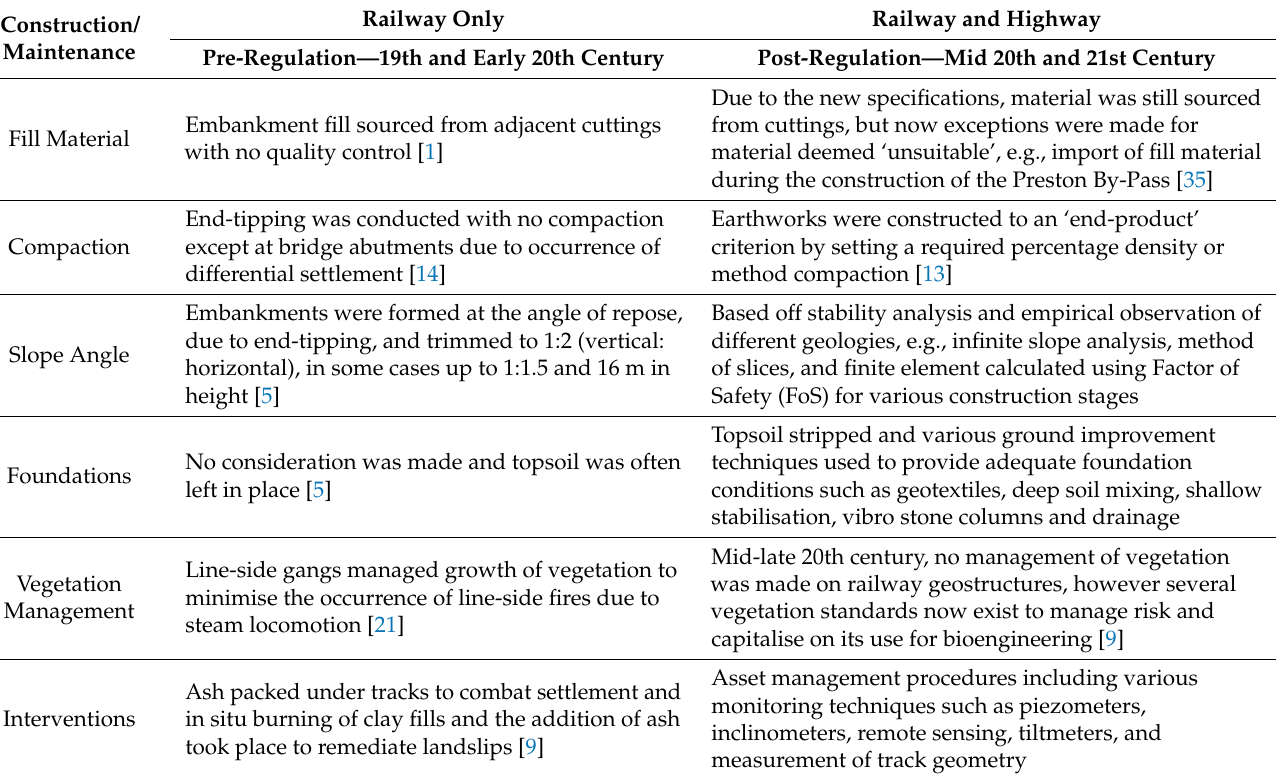
Table 1. Comparison between both the pre-regulation and post-regulation construction techniques for embankments used during the founding of the UK railway and highway (motorway) network.